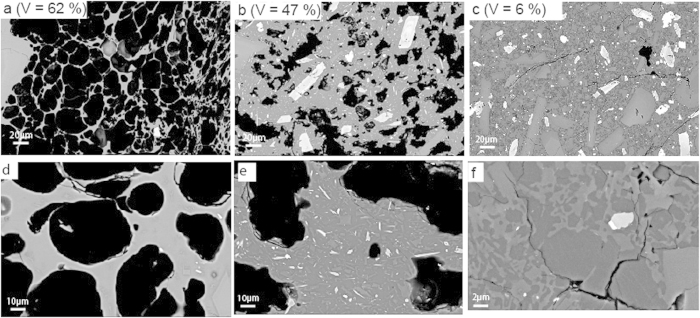
BSE images of representative clasts from Montagne Pelée.Images (a–c): vesiculated to dense clasts from May, 8th, 1902 D-PDC deposit. (a) the most vesiculated clasts (bulk rock vesicularity >50%) of D-PDC display characteristic pumiceous textures with subspherical and disconnected vesicles, 10 to 100 μm in diameter, with thin bubble walls (<5 μm) and only rare microlites in glass. (b) intermediate clasts have decreasing bulk rock vesicularity, increasing microlite content and bubble wall thickness. (c) the densest clasts display heterogeneous textures: most clasts display rare, irregular and small (<20 μm) vesicles with 12 area % cristobalite precipitates. Cristobalite corresponds to the dark grey phase. (d) glassy vesiculated clast from May, 8th, 1902 D-PDC. (e) highly microcrystalline dense clast from 1929 C-PDC. (f) cristobalite precipitates - dark grey phase (dense clasts, May, 8th, 1902 D-PDC): these are found either as cracked infillings in some large vesicles (up to 30 μm) or as pervasive patches (few μm to 200 μm in size).